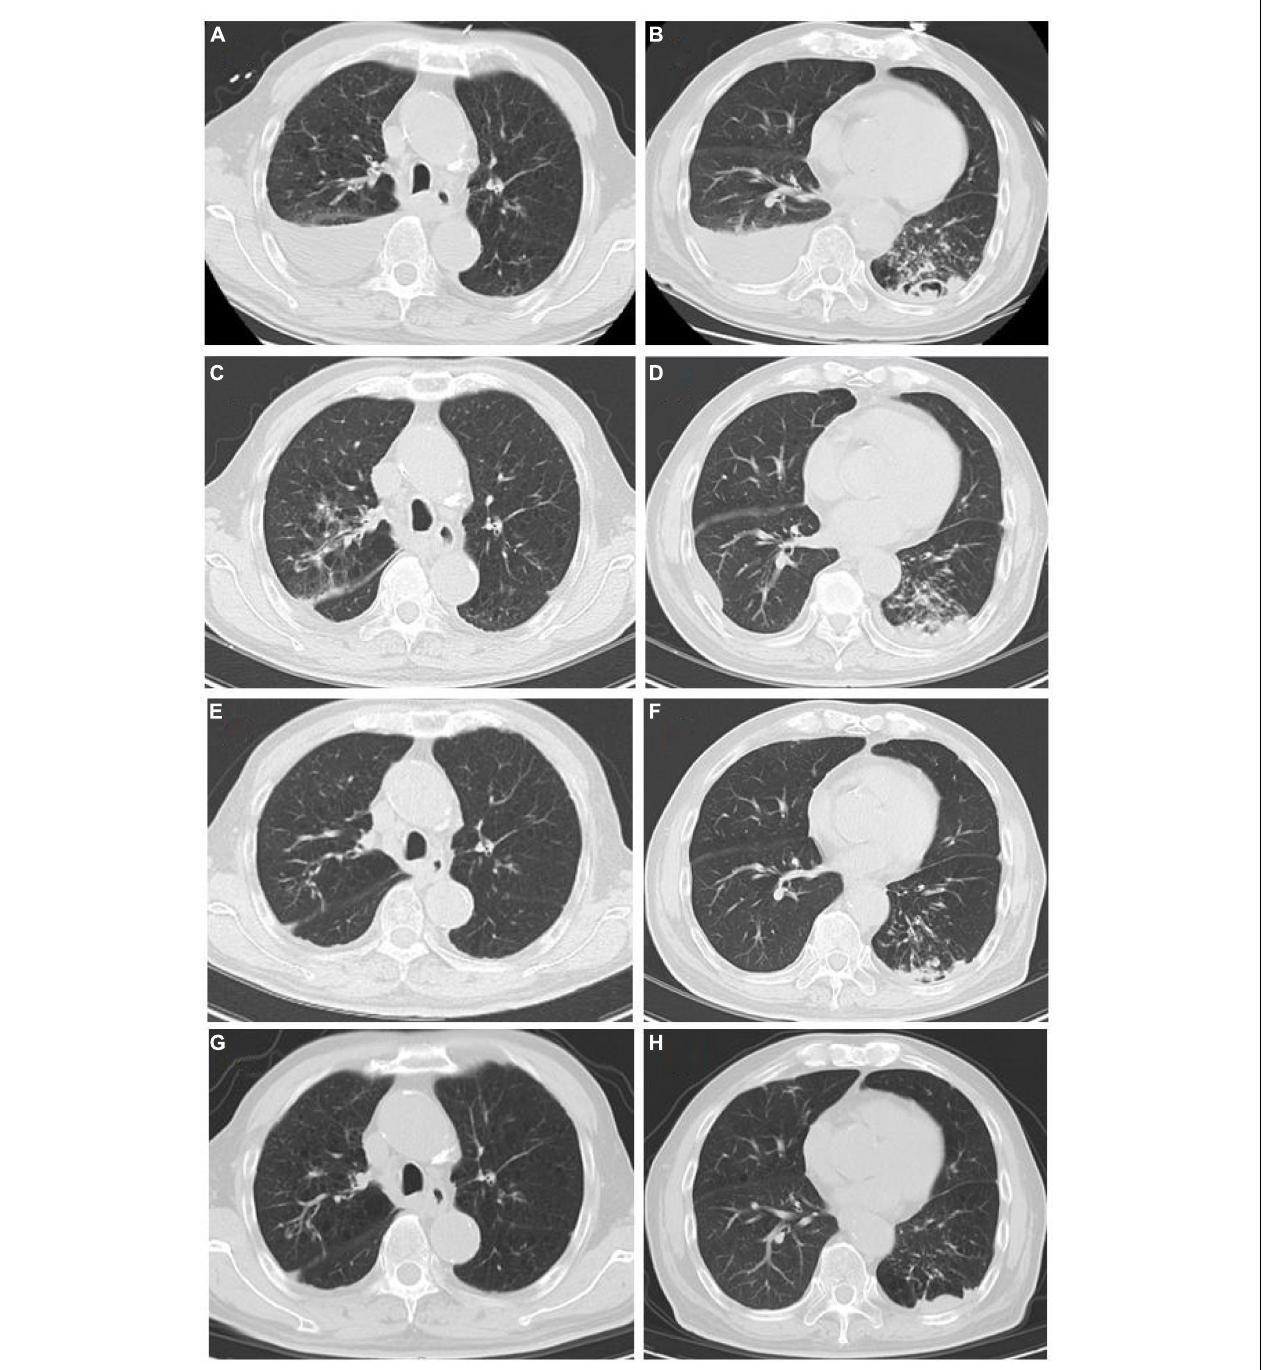
FIGURE 1 | (A,B) Chest CT scan at the first admission (June 8). (A) Both lungs had increased field permeability; the density of the fluid in the right pleural cavity was affected, and emphysema was considered; the right pleural effusion was accompanied by local atelectasis. (B) Bilateral pleural fluid density shadows, multiple patchy high-density shadows in the left lower lung, and a local cavity formation led to suspected bilateral pleural effusion and infectious lesion in the left lung. (C,D) Chest CT scan after conventional antibacterial treatments (June 21): Infectious lesions in both lungs increased, left pleural effusion increased, and right pleural effusion decreased as compared to (A,B) . (E,F) Chest CT scan after the antituberculosis and antifungal treatments (September 2): The scope of infectious lesions in both lungs was the resolution, the left lower lung was more obvious, and the pleural effusions on both sides were significantly reduced as compared to (C,D) . (G,H) Chest CT at follow-up (December 21): The infectious lesions in both lungs were obviously resolved as compared to (E,F) .